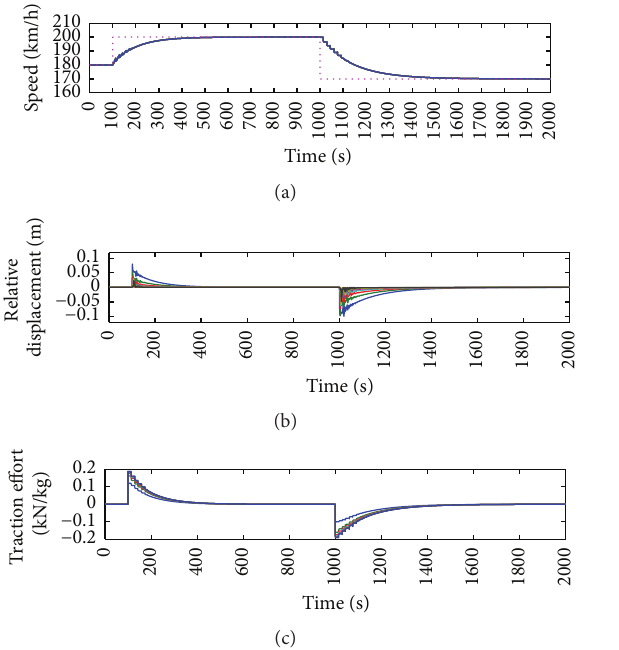
Figure 5: Optimal curves for each car under the fuzzy constrained predictive controller with actuator dynamics.